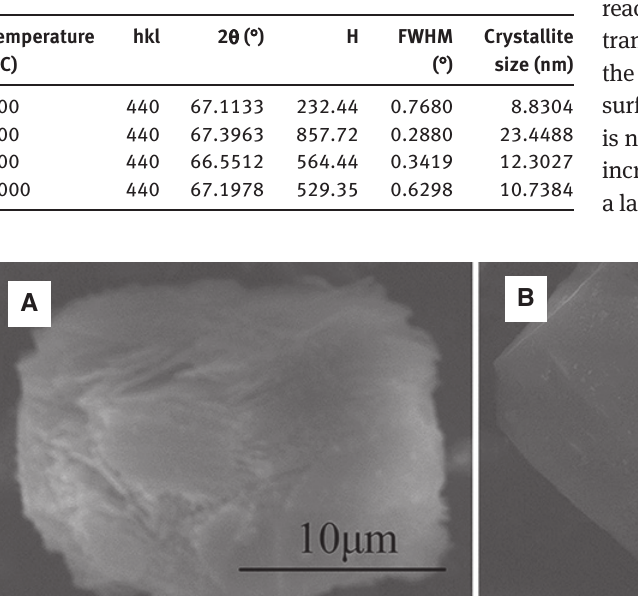
Table 5: Analysis of XRD patterns of alumina products.